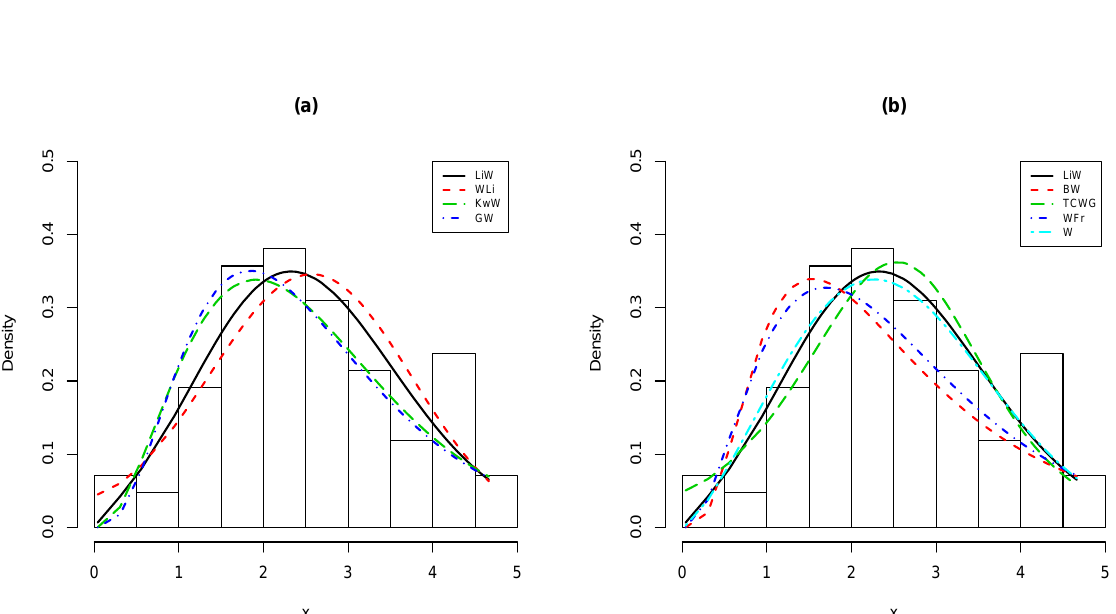
Figure 3 - The fitted densities for the: (a) LiW, WLi, KwW and GW models; (b) LiW, BW, TCWG, WFr and W models (data set I).